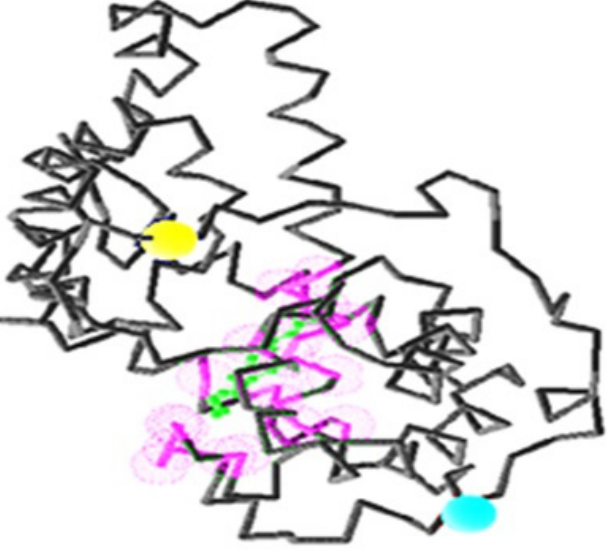
Figure 9. The active site of DehD. The Asp and Glu binding sites are colored blue; the Phe and Tyr binding sites are colored yellow; the Val, Ile and Leu binding sites are colored purple; the other residues (Ala, Gly, Met, Trp, Pro, Ser, Thr, Cys, Asn, Gln, Lys, Arg, and His are colored green).